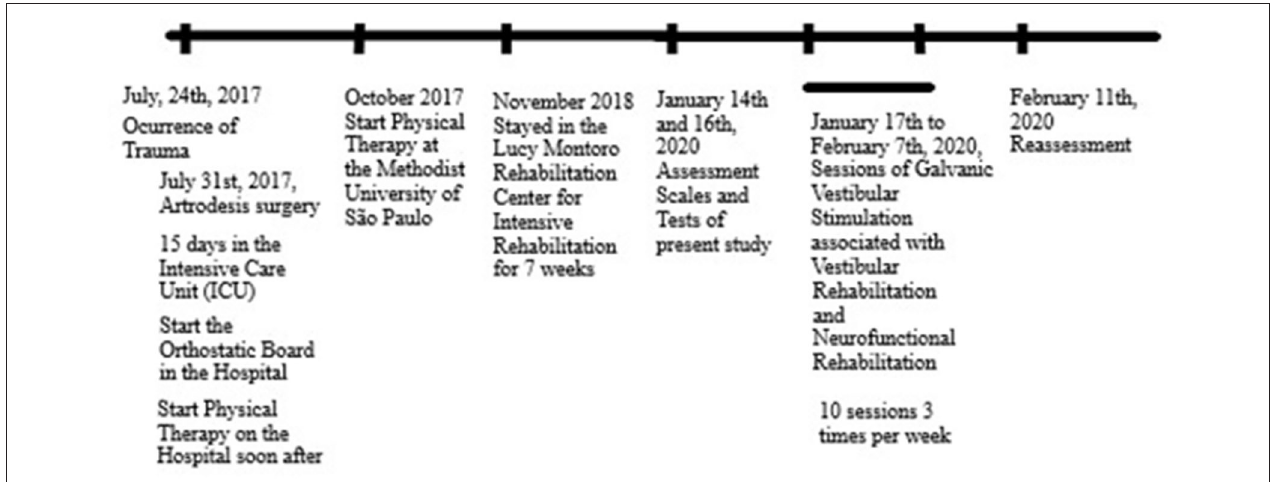
FIGURE 1 | Timeline of the important data of the case care.